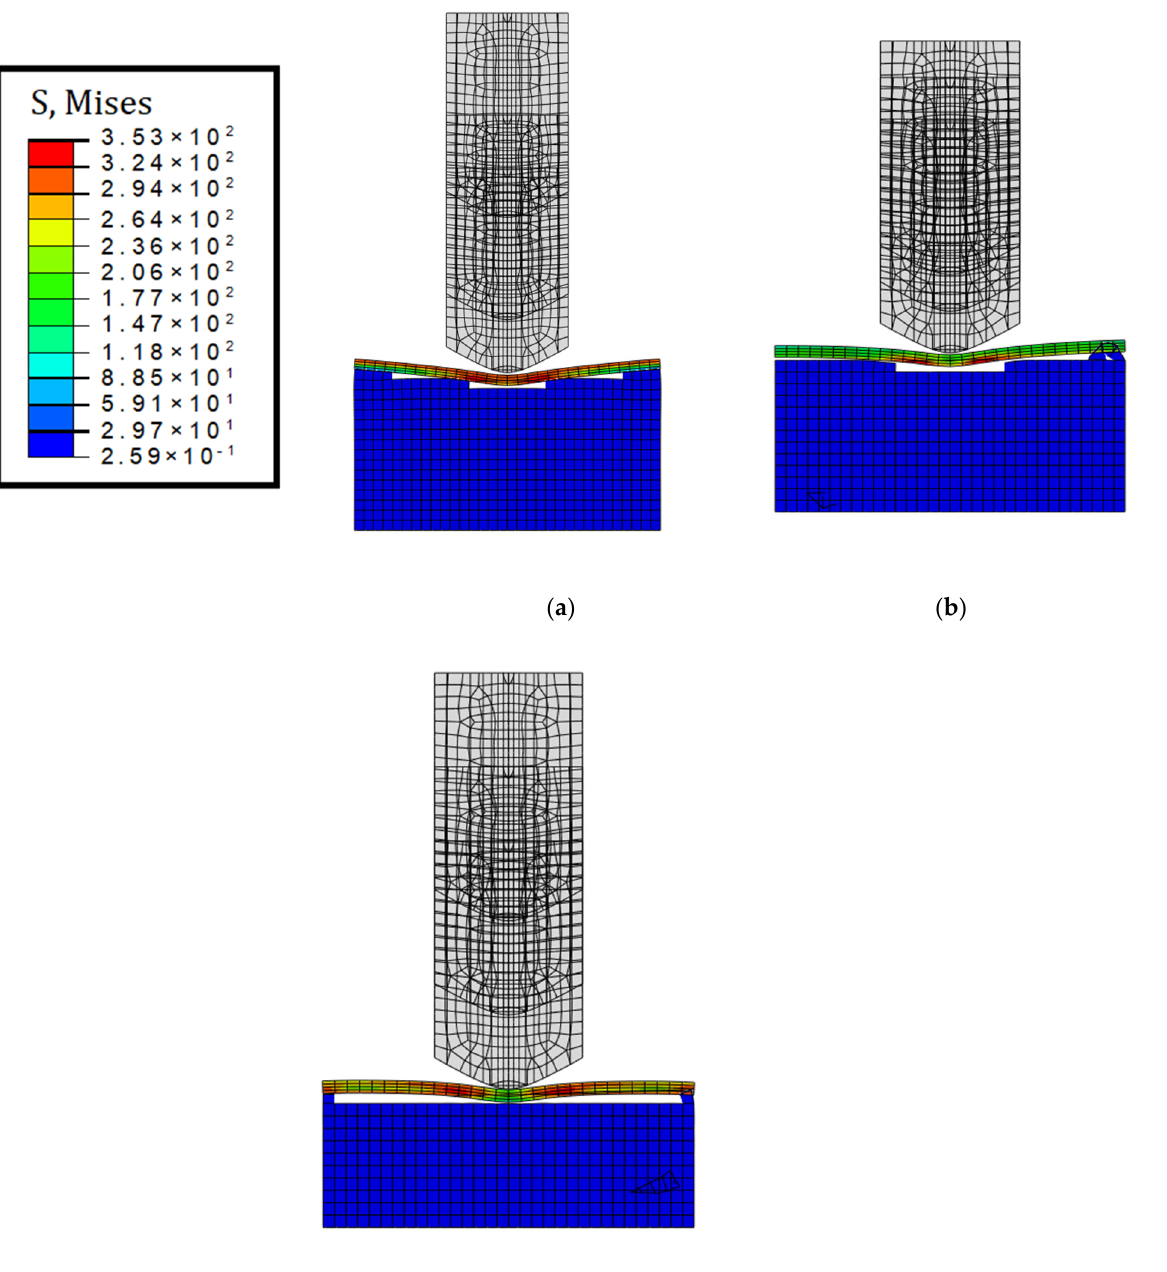
Figure 9. FE Von Mises stresses after multiple impacts. ( a ) 1st impact; ( b ) 2nd impact; ( c ) 3rd impact.